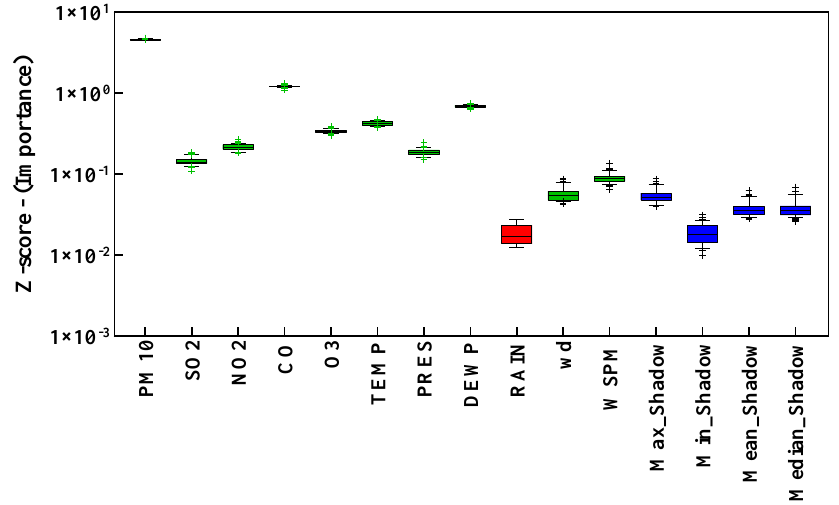
Figure 5. Boxplot of median Z-scores attained by the Boruta-XGB